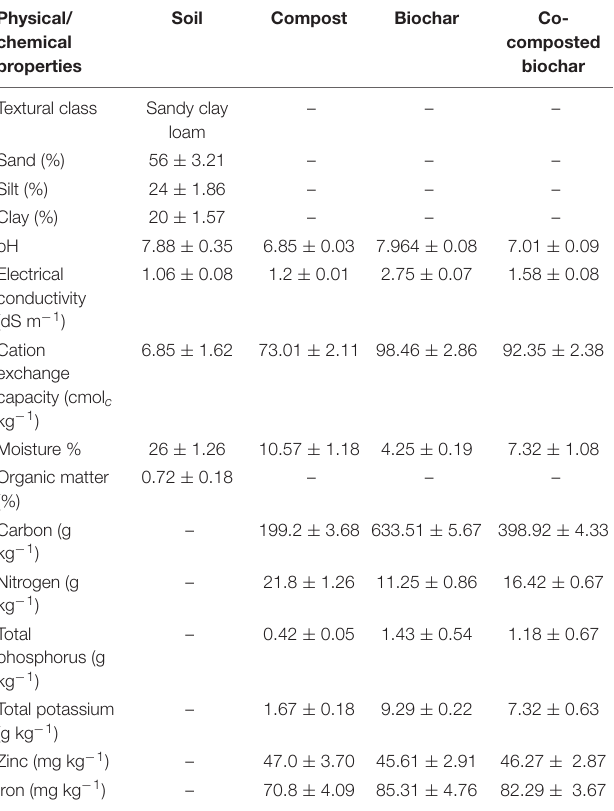
TABLE 1 | Physicochemical characteristics and nutritional composition of compost, biochar, co-composted biochar, and soil utilized in this